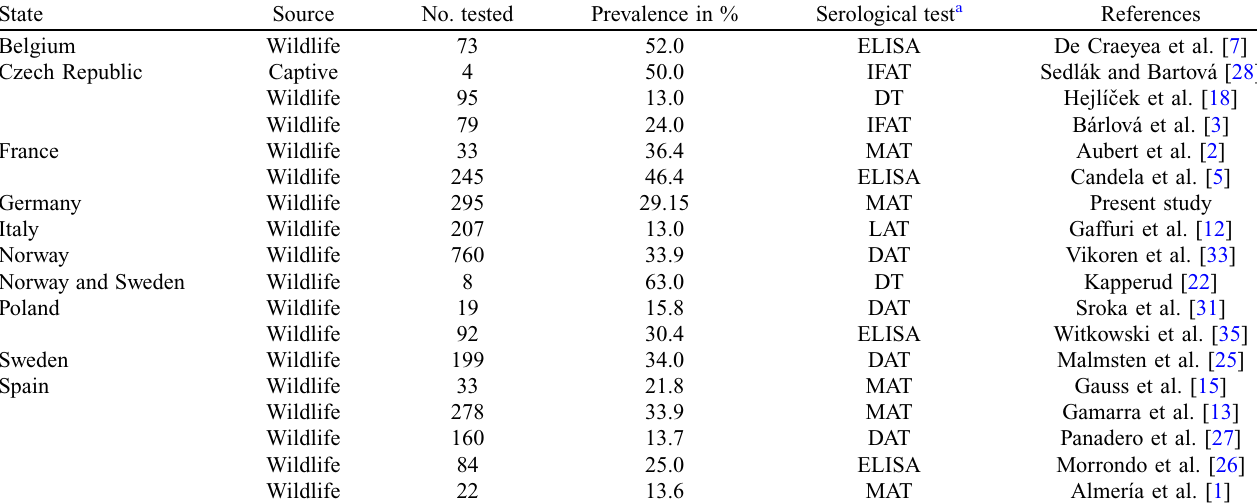
Table 2. Seroprevalence of Toxoplasma gondii in roe deer from Europe.